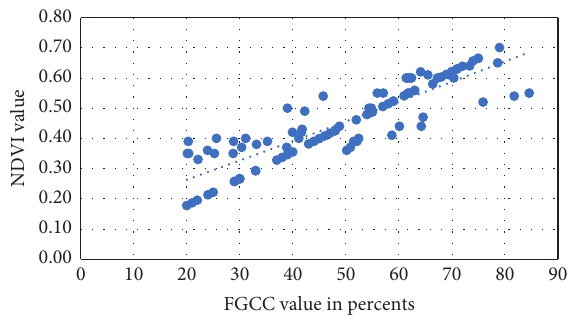
Figure 3: Approximation of the polynomial model for FGCC into NDVI conversion for tomato.